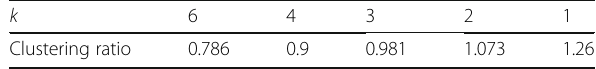
Table 3 Clustering ratio of different k values